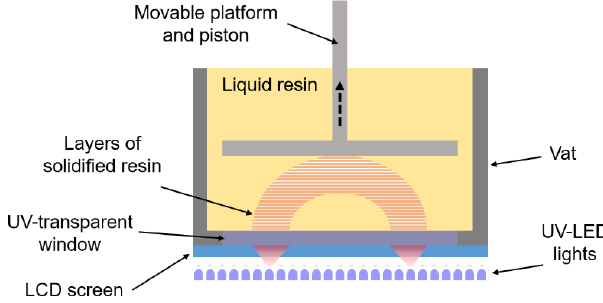
Figure 7. Schematic of a typical LCD printing method.